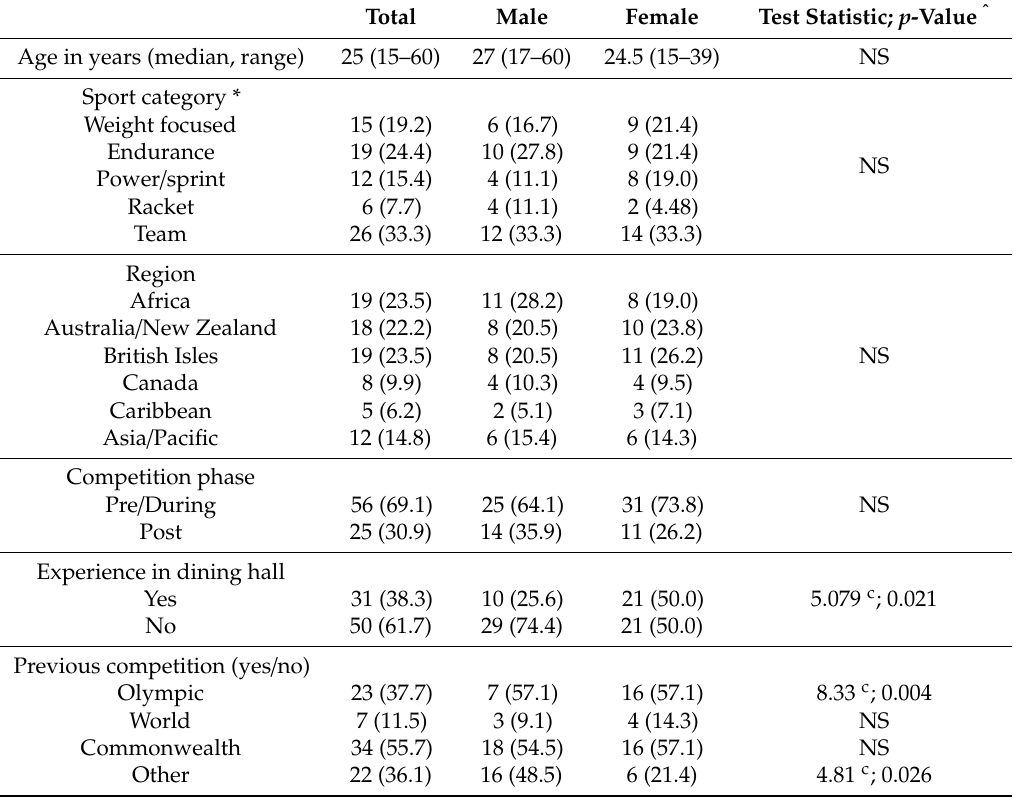
Table 1. Demographic characteristics of participants ( n =